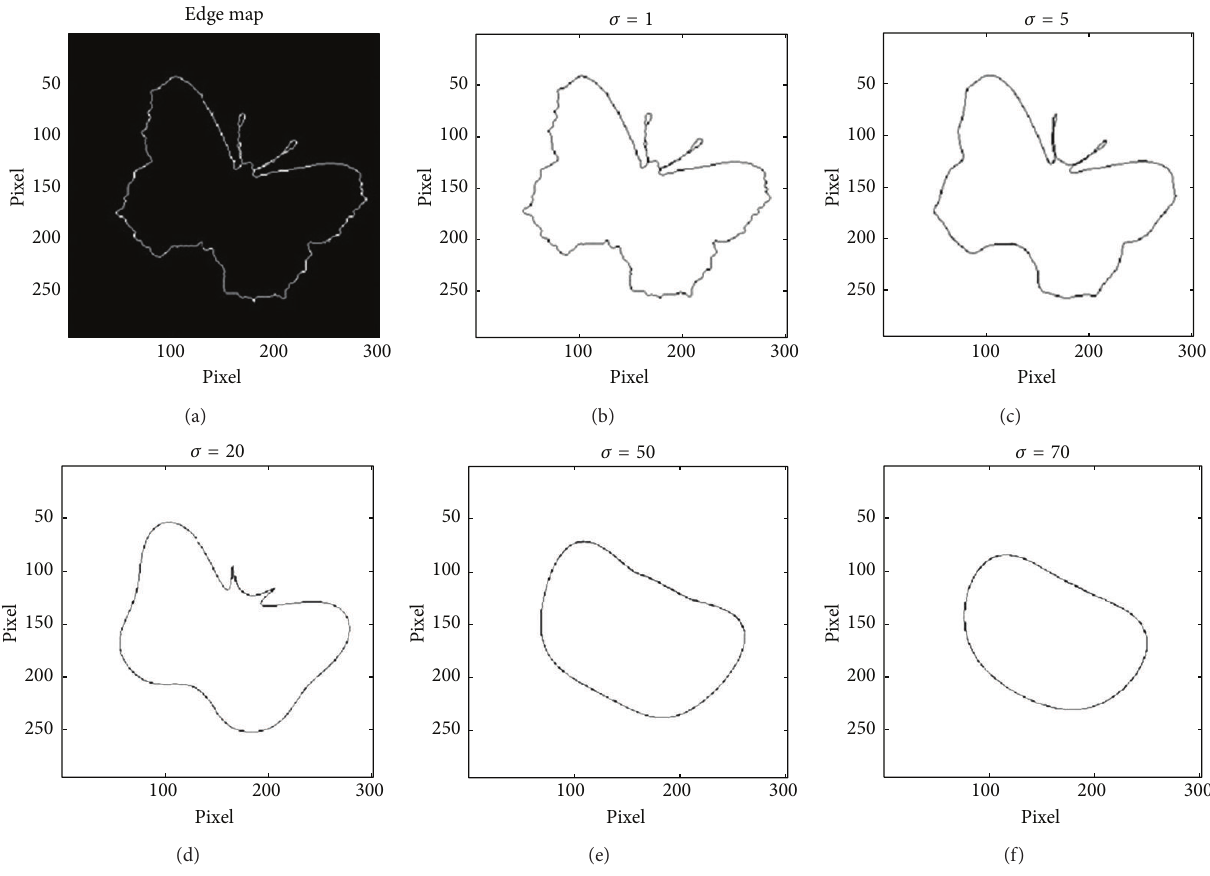
Figure 4: The evolution of image contour curve. (a) Original image; (b) the evolution of contour curve when 𝜎 = 1 ; (c) the evolution of contour curve when 𝜎 = 5 ; (d) the evolution of contour curve when 𝜎 = 20 ; (e) the evolution of contour curve when 𝜎 = 50 ; (f) the evolution of contour curve when 𝜎 = 70